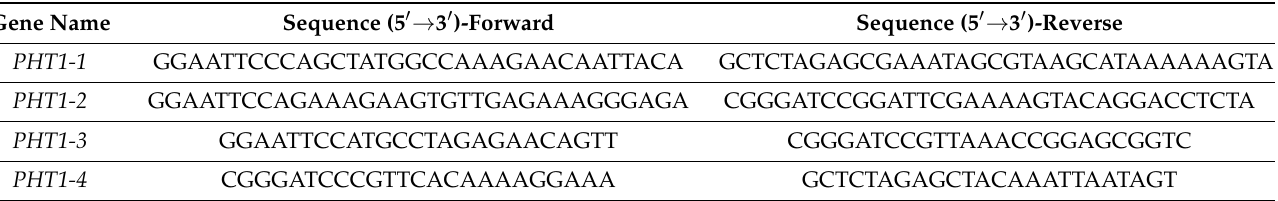
Table 3. Sequences of full-length primers for VcPHT1s